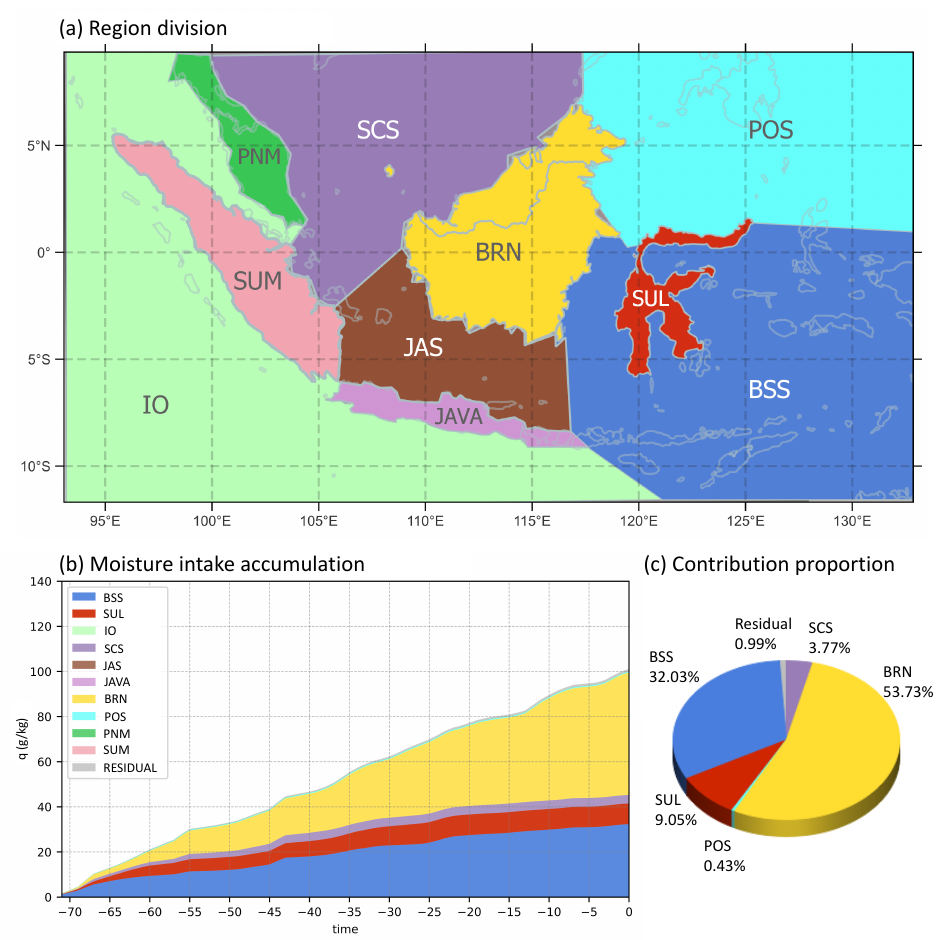
Figure 7. The moisture source contributions by different regions responsible for the extreme rainfal event. ( a ) The division of moisture source regions into 10 regions, including Peninsular Malaysia (PNM), Sumatera (SUM), Indian Ocean (IO), South China Sea (SCS), Java Sea (JAS), Java Island (JAVA), Borneo Island (BRN), Pacific Ocean and Surroundings (POS), Sulawesi Island (SUL), and Banda Sea and Surrounding (BSS). ( b ) The evolution of integrated moisture intake of the 10 sources along the trajectories in the target region. ( c ) The relative moisture contributions of different regions at the release time (0